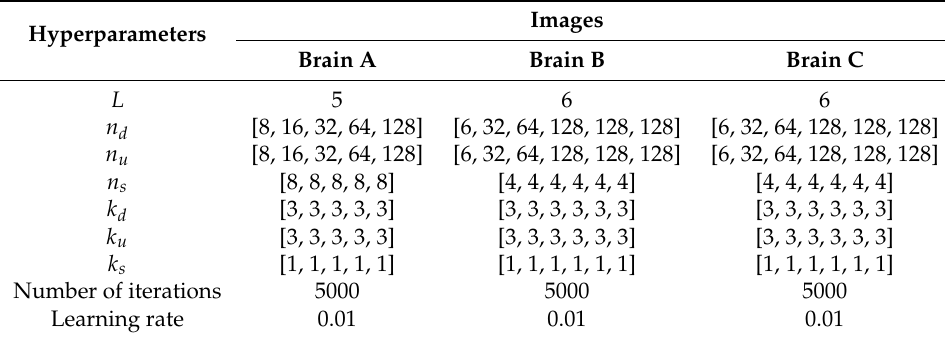
Table 1. Hyperparameter setting for the